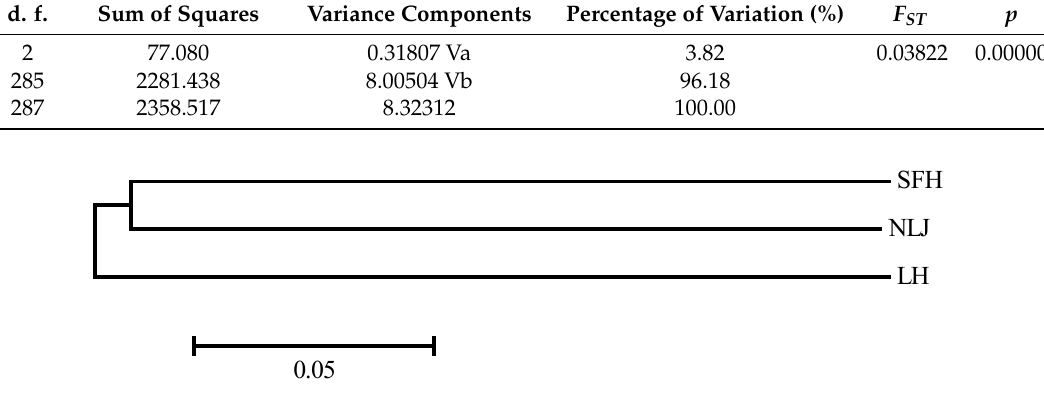
Figure 5. Neighbor-joining phylogenetic tree of Eriocheir s. s. based on Nei’s genetic distance. SFH, LH, and NLJ represent the Eriocheir s. s. from Suifenhe, Liaohe, and Nanliujiang river basins, respectively.